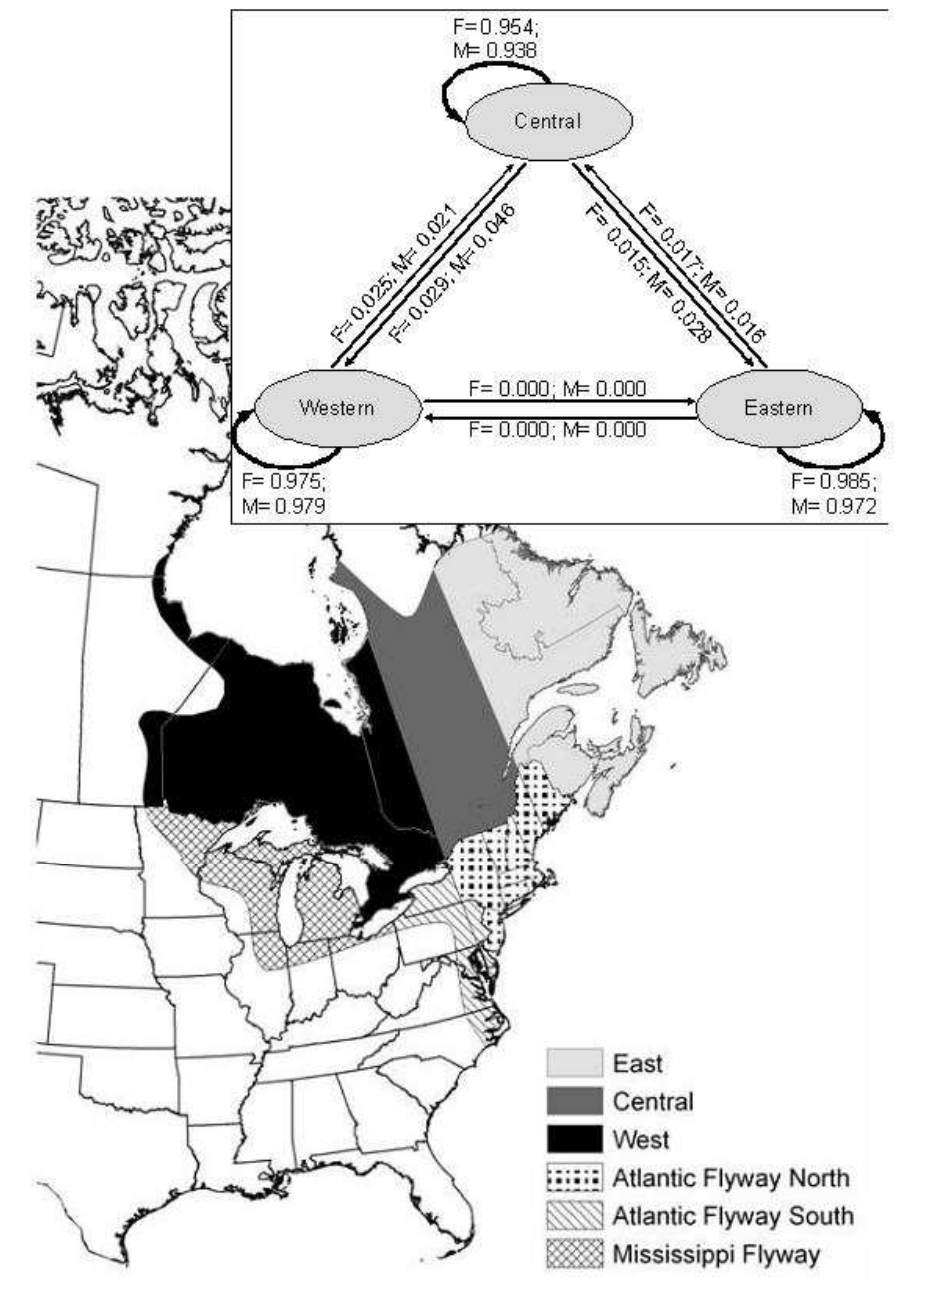
Fig. 1. Breeding and harvest area delineations for American Black Ducks ( Anas rubripes ). Arrows represent movements between populations and movement probabilities for males (M) and females (F). Curved arrows represent probabilities associated with birds remaining in the same area as their natal origin (modified from Zimpfer and Conroy 2006). Origins are constrained to the recognized North American range (Longcore et al.